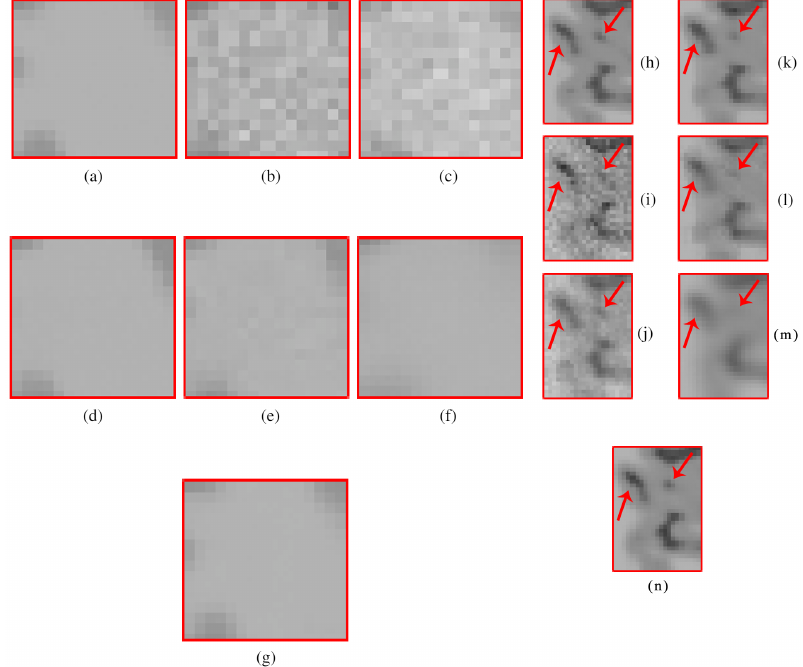
Figure 8. Zoom-in on the details of the regions labeled as “a” and “c” in Figure 6. Figure ( a – g ) correspond to the regions labeled as “a” and Figure ( h – n ) correspond to the regions labeled as “c”. Figure ( c – g ) and ( j – n ) correspond to the zoom-in on the results of the methods KSVD, PRINLM, BM4D, DnCNN and NLSD,